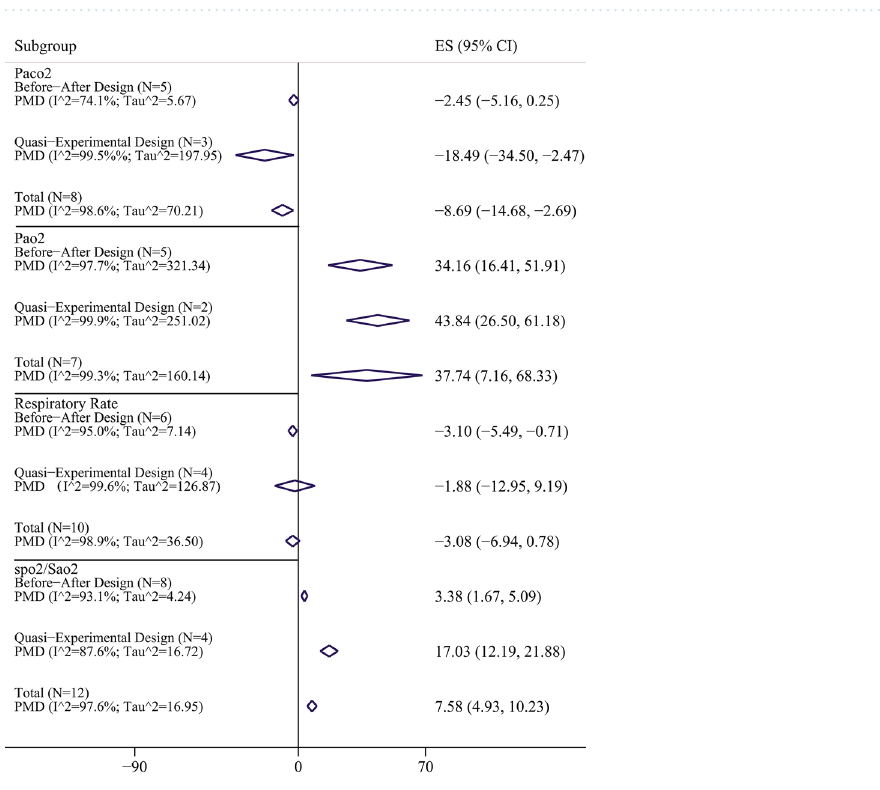
Figure 2. Forest plot for mean difference (MD) of PaO 2 /FIO 2 Ratio (mmHg) based on random effects model. The midpoint of each line segment shows the MD, the length of the line segment indicates the 95% confidence interval in each study, and the diamond mark illustrates the pooled MD.